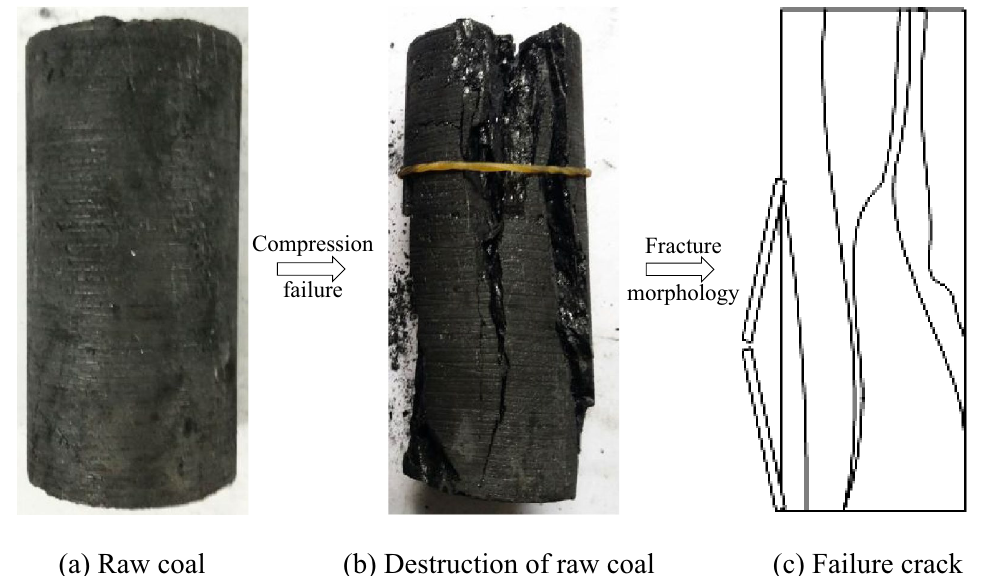
Figure 4. The failure forms of the briquette under uniaxial